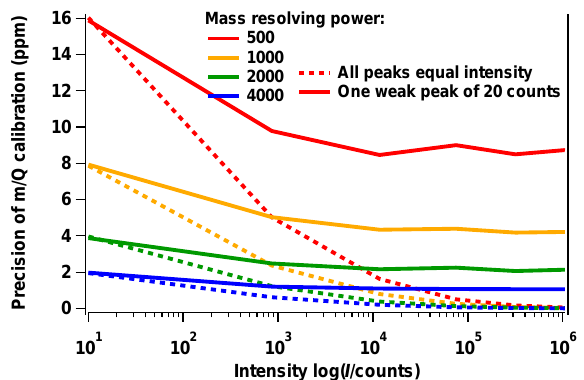
Figure 3. Mean precision in peak position arising from m/Q cali- bration as a function of the intensity of the calibrant ions. Dashed lines: all calibrant ions of equal intensity and as given on the x axis. Solid lines: as dashed, except one calibrant has peak intensity of only 20